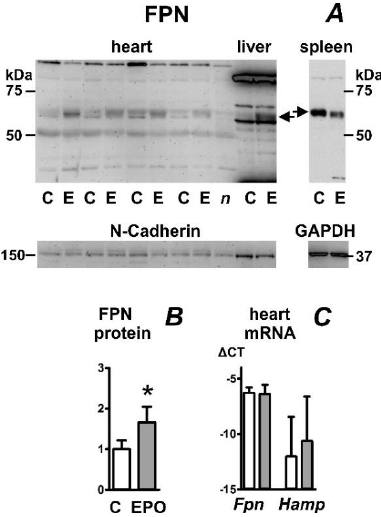
Figure 2. Effect of erythropoietin administration on ferroportin protein (FPN) content in rat heart, liver, and spleen. ( A ) Immunoblot of heart, liver, and spleen membrane protein fraction; ( B ) Quantifi- cation of heart immunoblot results, n = 4; ( C ) Real-time PCR quantification of heart Fpn and Hamp mRNA expressed as ∆ CT relative to Actb mRNA, n = 4. EPO was administered to female Wistar rats daily for four days at 600 U/rat, animals were sacrificed 24 h after last administration. In total, 40 µ g of membrane protein was loaded per well. C, samples from control rats; E, samples from EPO-treated rats. Samples were heated to 50 ◦ C prior to loading; n (negative control) represents a heart sample from EPO-treated rat, which was heated to 85 ◦ C. N-Cadherin or GAPDH is used as loading control, arrows indicate the ferroportin-specific bands. Asterisk denotes statistical significance ( p < 0.05).